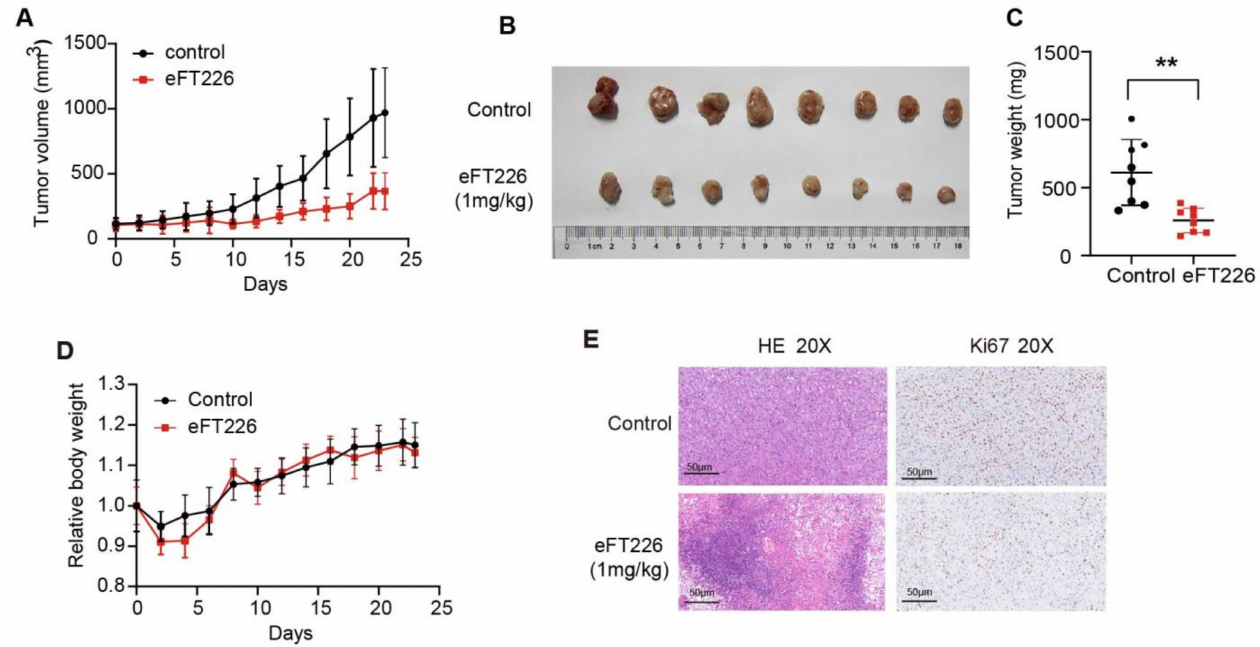
Figure 8. eFT226 suppresses Tsc2 -deficient tumor growth. Nude mice were subcutaneously inoculated with Tsc2 -deficient MEFs and then treated with vehicle (5% dextrose in water) (n = 8) or eFT226 (1 mg/kg, 1 times/week) (n = 8). ( A ) Tumor volume of nude mice was recorded every 2 days. ( B ) A representative picture of a tumor is shown as an inset. ( C , D ) The measurement of tumor weight and body weight. ( E ) Representative images of H&E and immunohistochemistry for Ki-67 from tumors. (Scale bars: 50 µ m). Error bars represent mean ± SD. ** p <